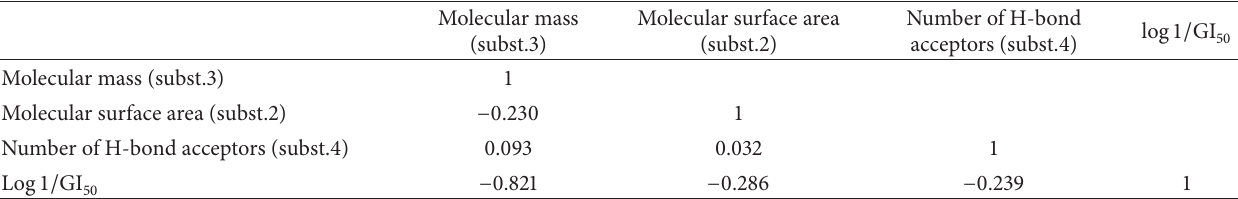
Table 2: Correlation matrix of the independent variables used in the final model demonstrating the degree of correlation.